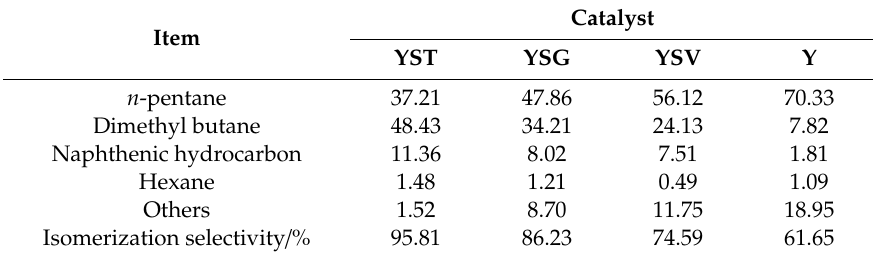
Table 2. Performance of di ff erent catalysts for